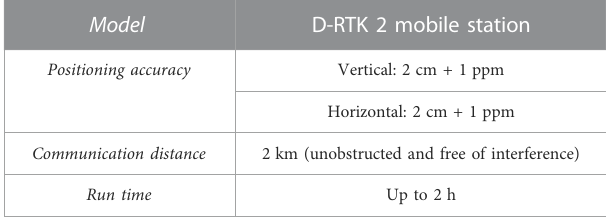
TABLE 3 D-RTK 2 mobile station ’ s speci fi cations (ppm: for every 1 km increase in distance, the accuracy will be 1 mm less. For example, the horizontal accuracy is 1.1 when the receiving end is 1 km away from the base